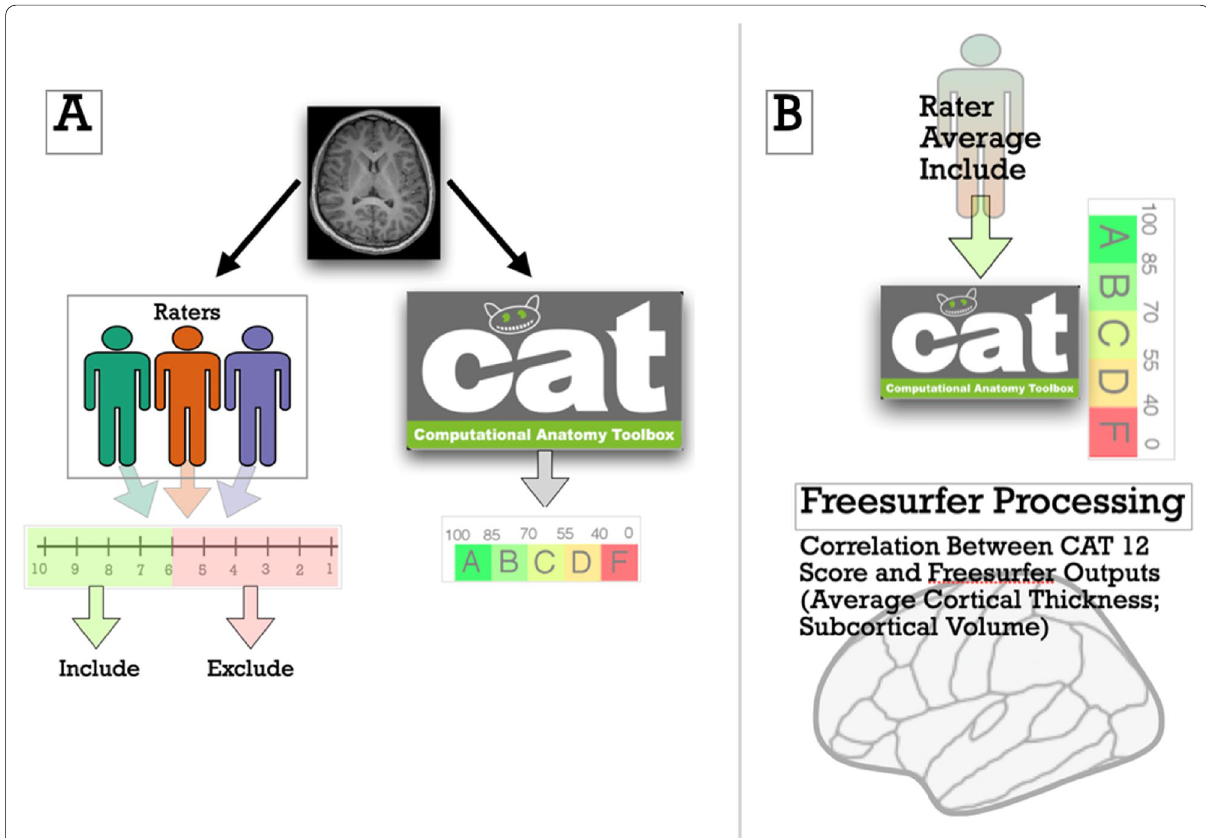
Fig. 1 Graphic depiction of the study’s procedures. Structural MRI images were rated by multiple trained research assistant and also processed in the CAT12 toolbox ( a ). Human raters rated each image and then these ratings were averaged; MRI images, with a rating > 6, were then processed in Freesurfer, and relations between CAT12 scores and Freesurfer outputs were examined ( b